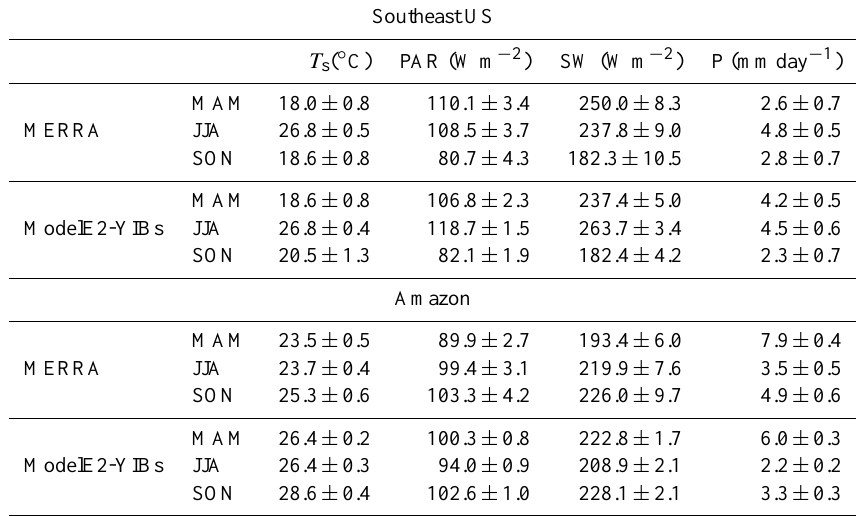
Table 1. Regionally averaged meteorological variables with standard deviation from MERRA reanalysis and NASA ModelE2-YIBs in the southeast US and the Amazon.